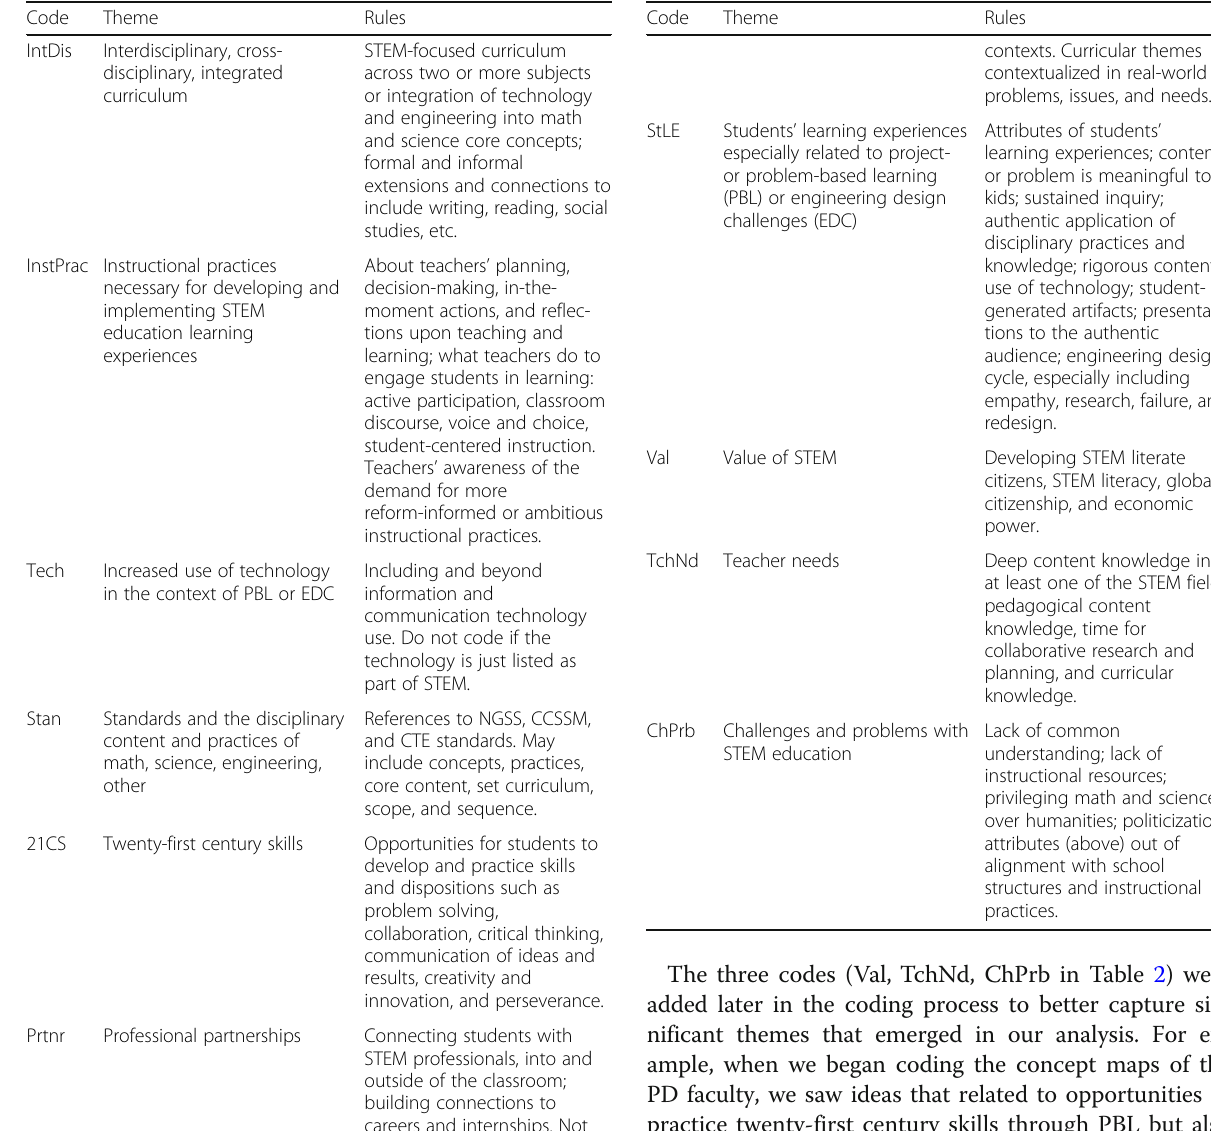
Table 2 Coding themes and